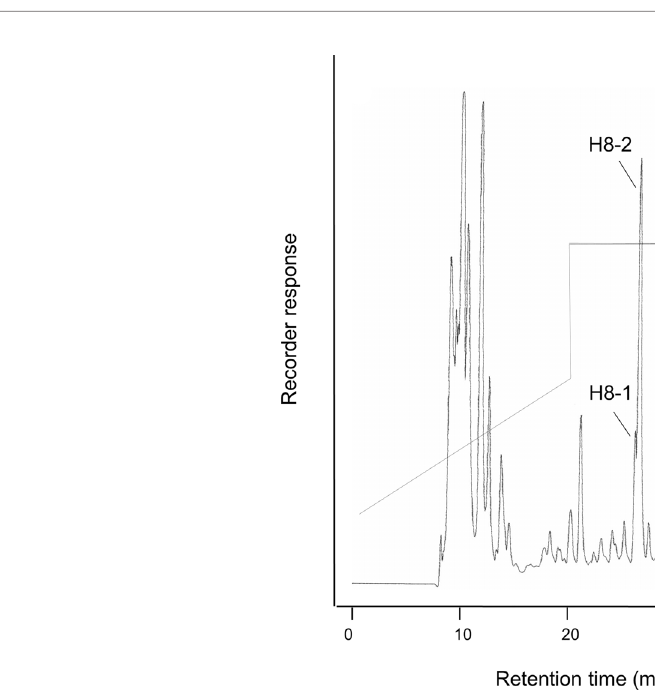
FIGURE 1 | HPLC fractions of L. fermentum ALAL020 culture supernatant. The culture supernatant was fractionated with reverse-phase chromatography by HPLC on an ODS (C18)